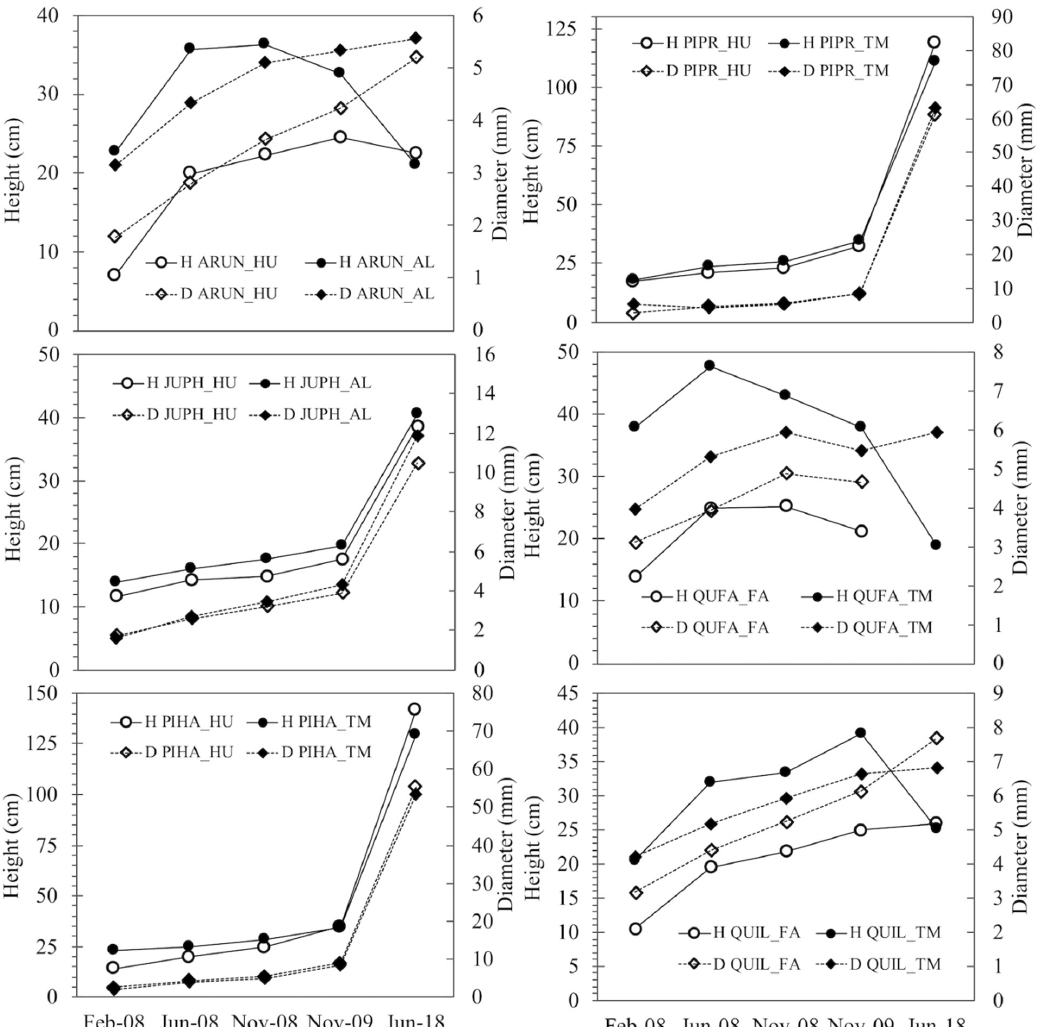
Figure 4. Evolution of the mean values of plant height and basal diameter for both stocklots in a species throughout the 10-year period studied. In 2008 (planting year), planting (February), spring (June), and post-summer (November) values are shown. Bars correspond to standard deviations. See Table 1 for abbreviations.